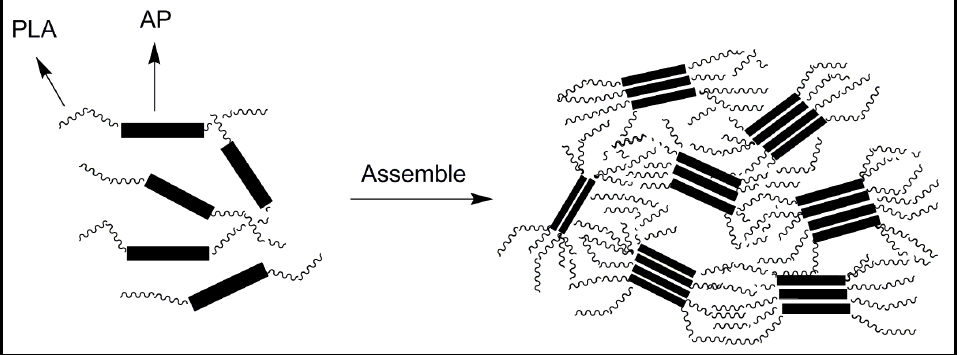
Figure 13. Schematic representation of the self-assembling of PLA- b -AP- b -PLA triblock